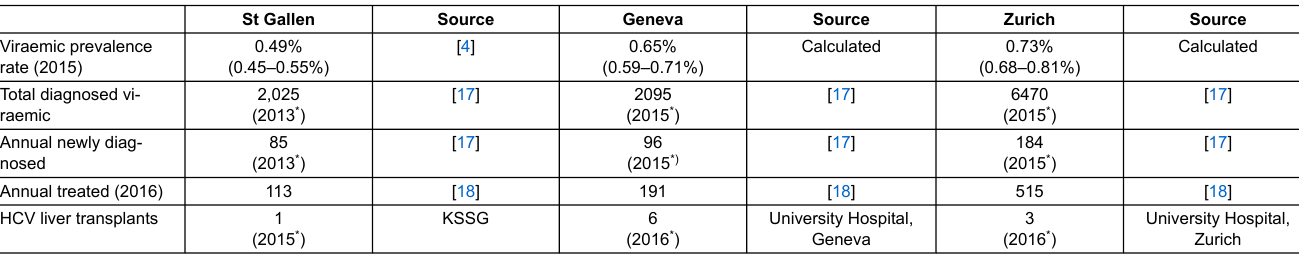
Table 1: Inputs by cantonal model.